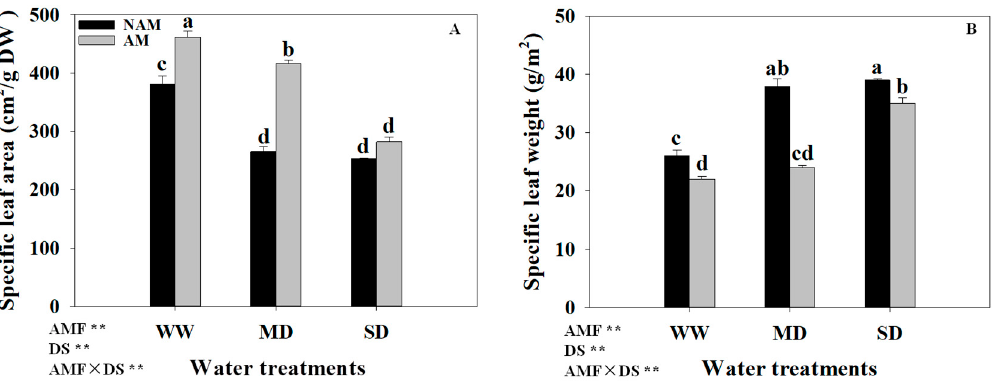
Figure 4. Effect of the arbuscular mycorrhizal fungus (AMF) Rhizophagus intraradices on ( A ) specific leaf area (SLA) and ( B ) specific leaf weight (SLW) of Catalpa bungei seedlings under DS. NAM, non-AMF-inoculated; AM, AMF-inoculated; WW, well-watered; MD, moderate drought; SD, severe drought; DS, drought stress. Different lowercase letters above the bars indicate significant differences ( p < 0.05) among treatments. Values are means ± SE ( n = 3). Two-way ANOVA output: ns, not significant; ** p < 0.01.